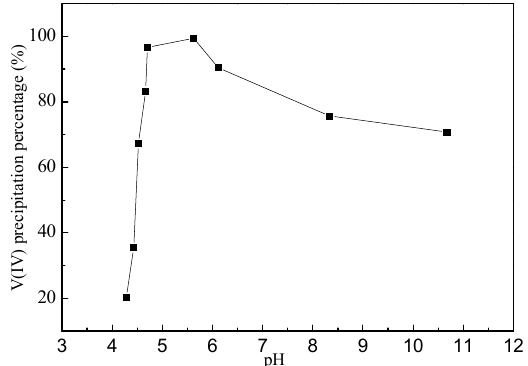
Figure 7. Effect of final pH on the vanadium precipitation percentage.